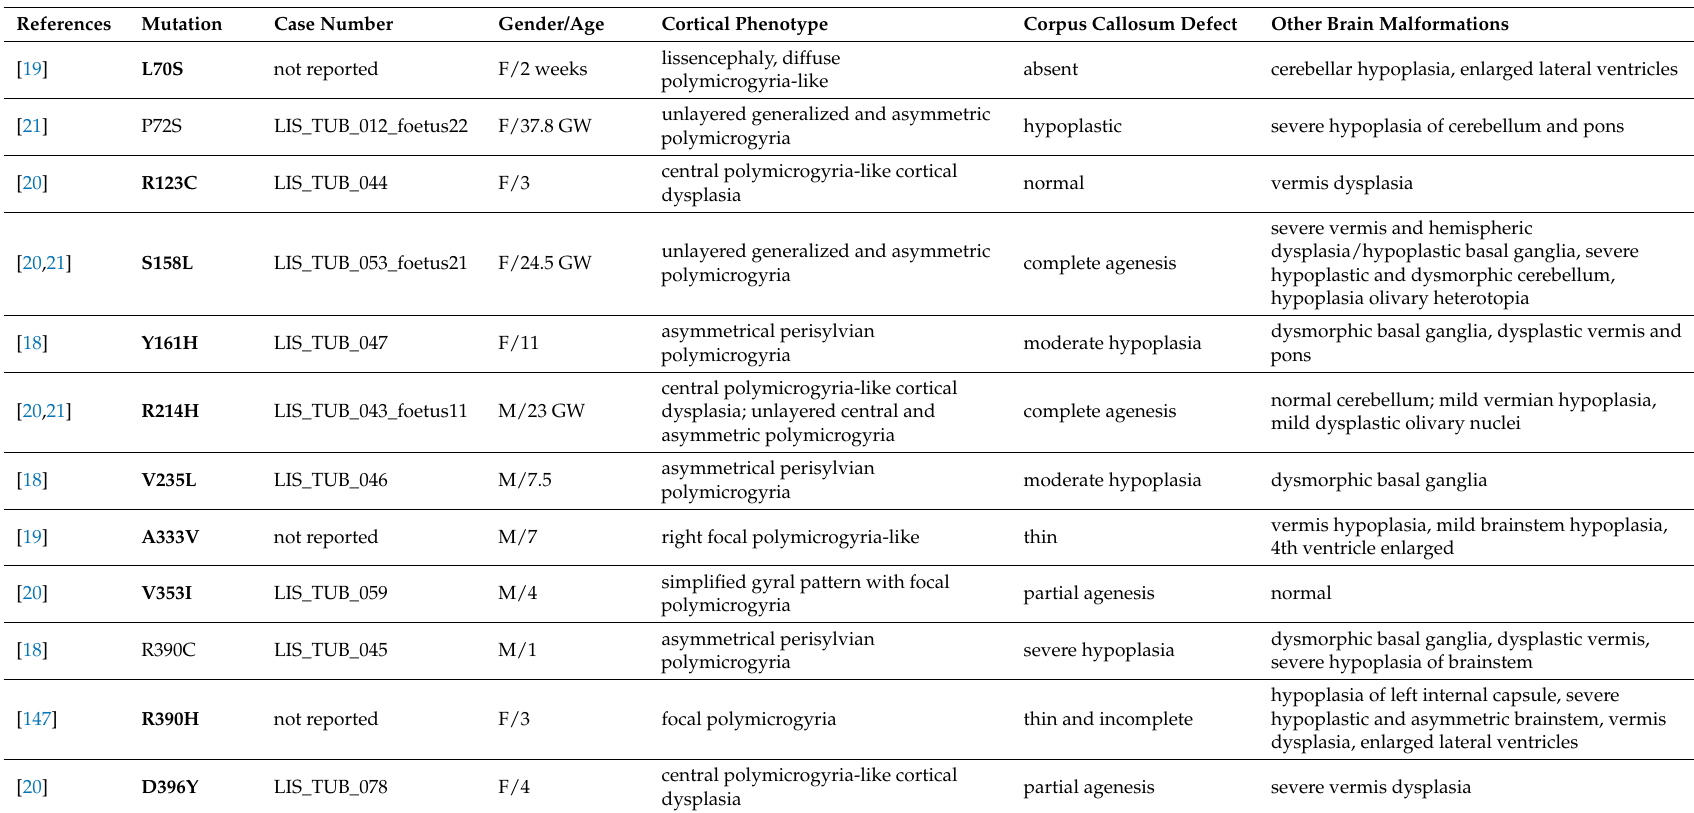
Table 4. Tuba1a mutations leading to polymicrogyria